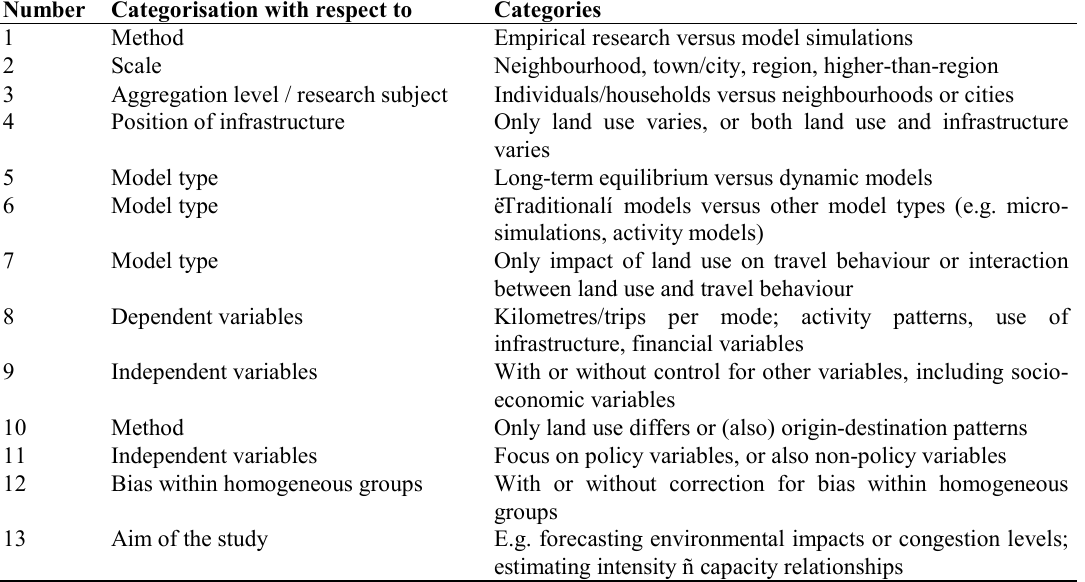
Table 1: Categorisations of research into land-use impact on